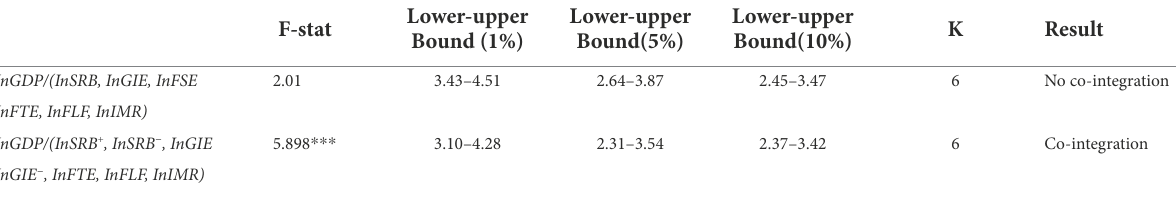
TABLE 4 ARDL and NARDL bound testing approaches for